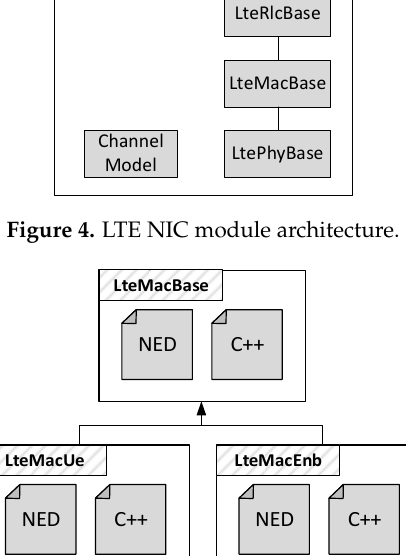
Figure 5. Example of inheritance of NED structure and C++ class.